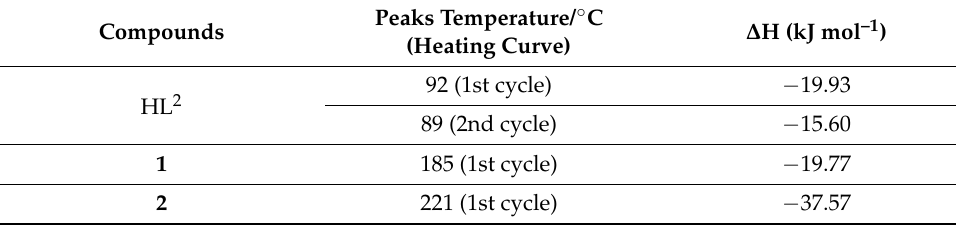
Figure 7. Differential scanning calorimetry (DSC) curves for compounds 1 and 2 . Table 4. Phase transformation and thermal stability for the compounds.